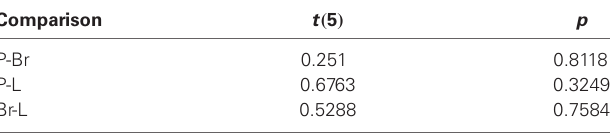
Table 1 | Sensitivity d (cid:48) for N = 1 across conditions